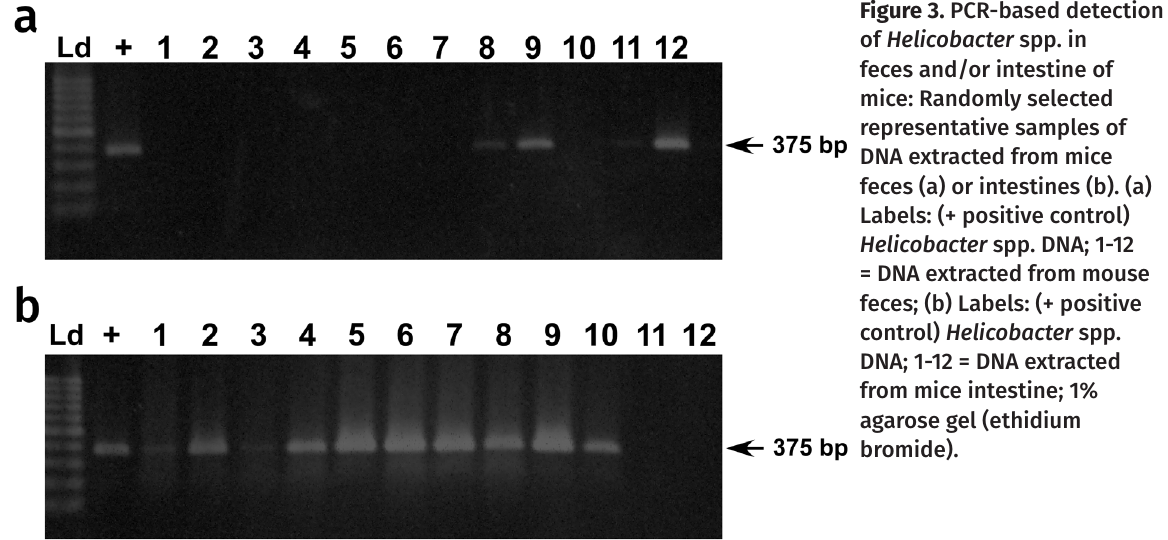
Figure 3. PCR-based detection of Helicobacter spp. in feces and/or intestine of mice: Randomly selected representative samples of DNA extracted from mice feces (a) or intestines (b). (a) Labels: (+ positive control) Helicobacter spp. DNA; 1-12 = DNA extracted from mouse